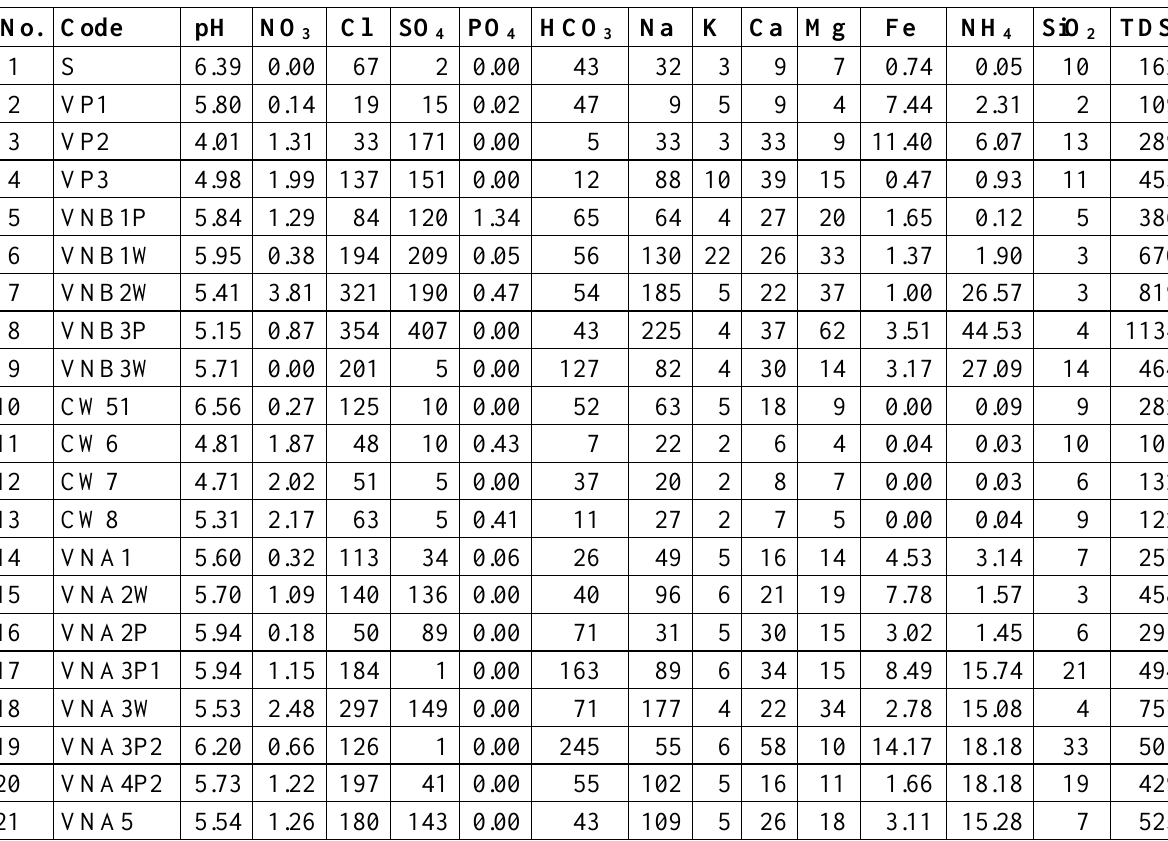
Table A2: Ionic composition of the water samples collected from the Vasi peatland complex in 2015. All the macro ions are reported in mg L -1 .